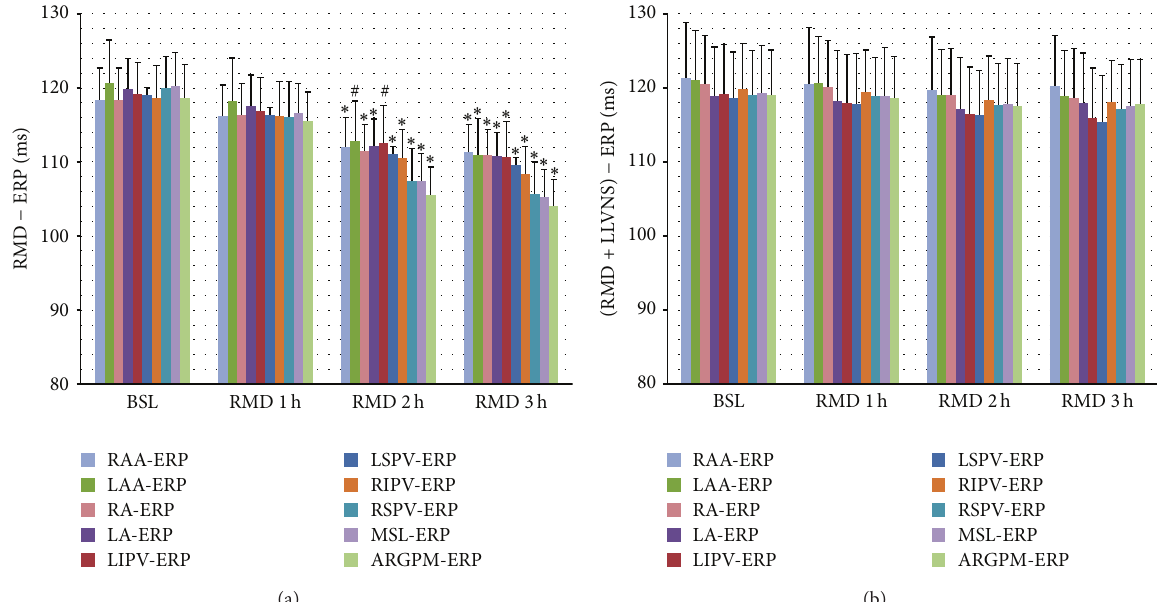
Figure 3: Effects of LLVNS on ERP and its gradient. LLVNS reversed the decrease in ERP and increase in ERP gradient that was induced by RAP. # 𝑃 < 0.05 and ∗ 𝑃 < 0.01 compared with baseline levels using the paired 𝑡 -test. ERP: effective refractory period; BSL: baseline level; RMD: remodeling; LLVNS: Low-level vagosympathetic nerve stimulation.